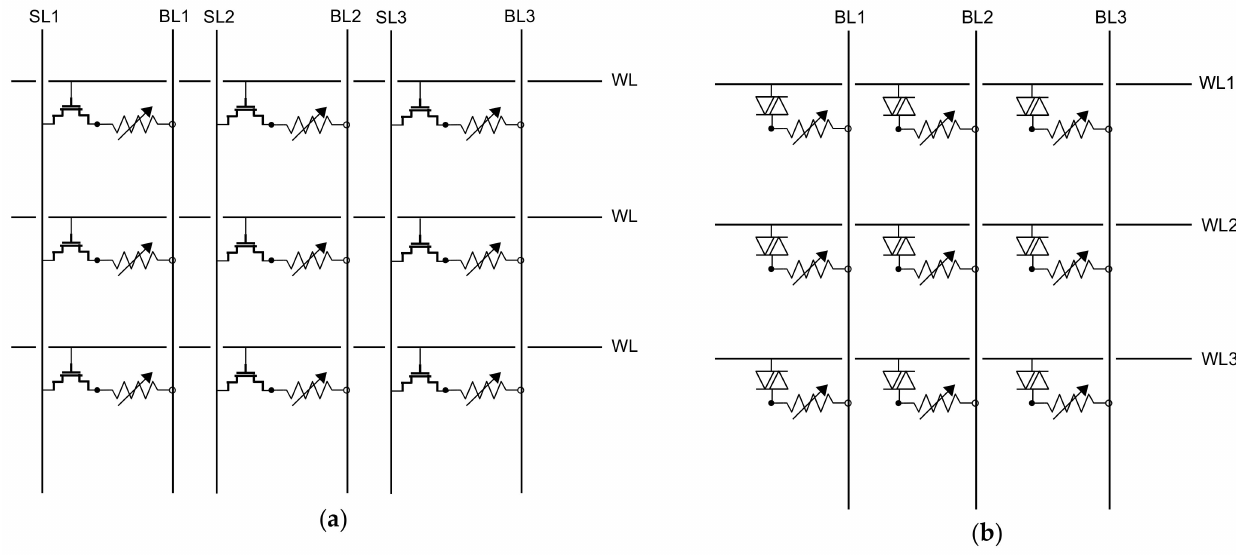
Figure 1. Array architectures for RRAM integration ( a ) 1T1R ( b )